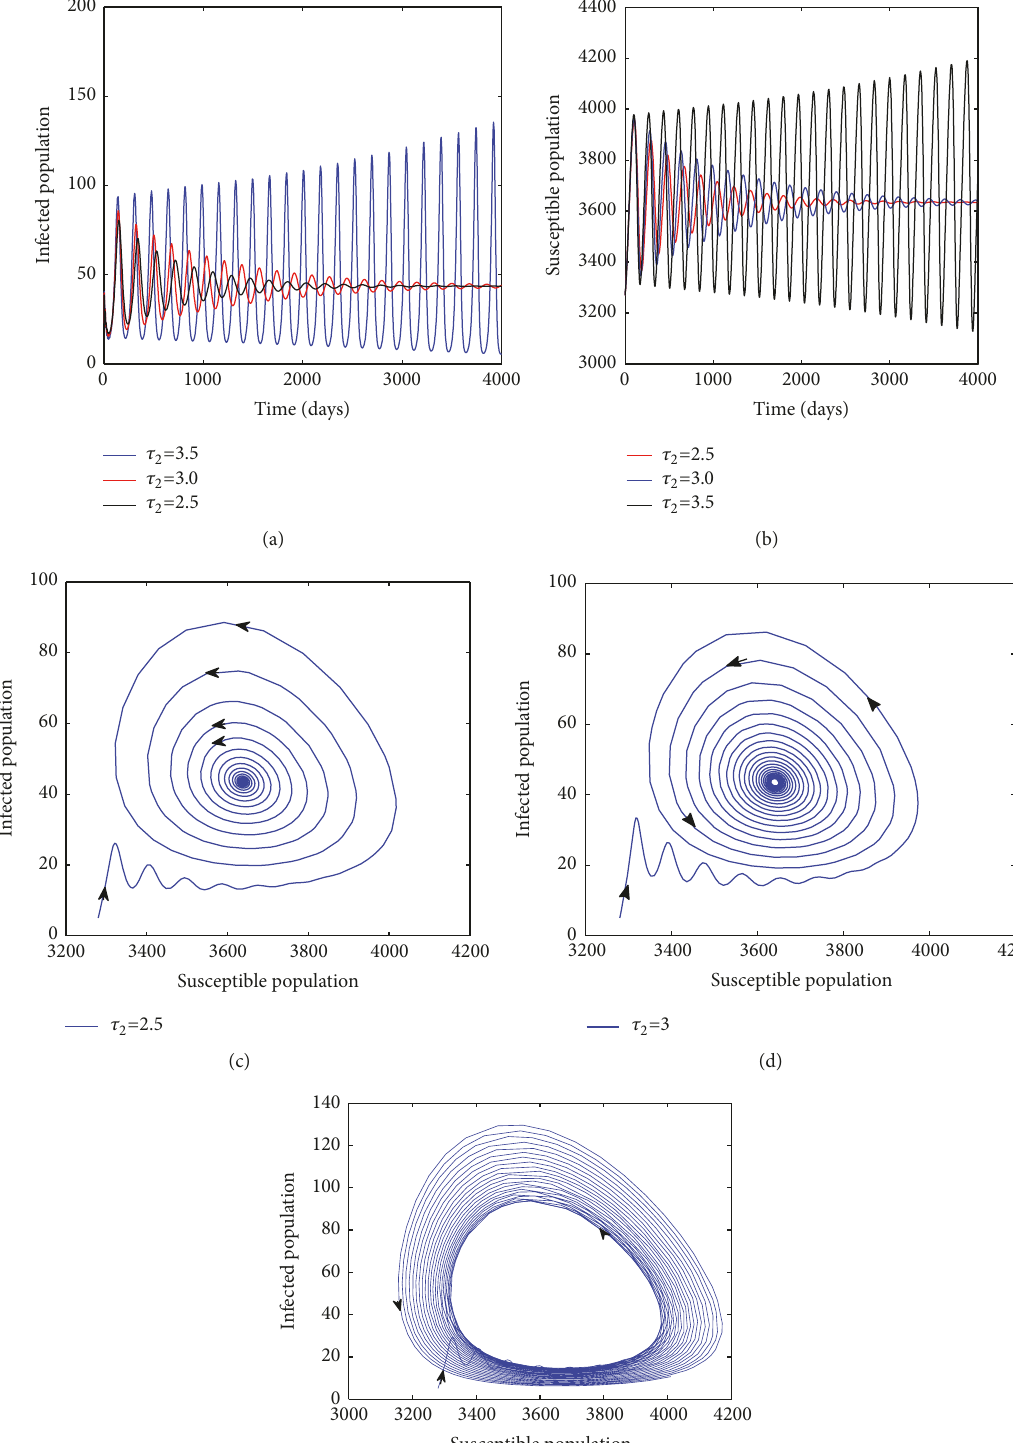
Figure 6: The effect of varying 𝜏 2 on the dynamics of model (1). The delay 𝜏 2 was chosen as 𝜏 2 = 2.5, 3, 3.5 . All other parameters remain as stated in Table